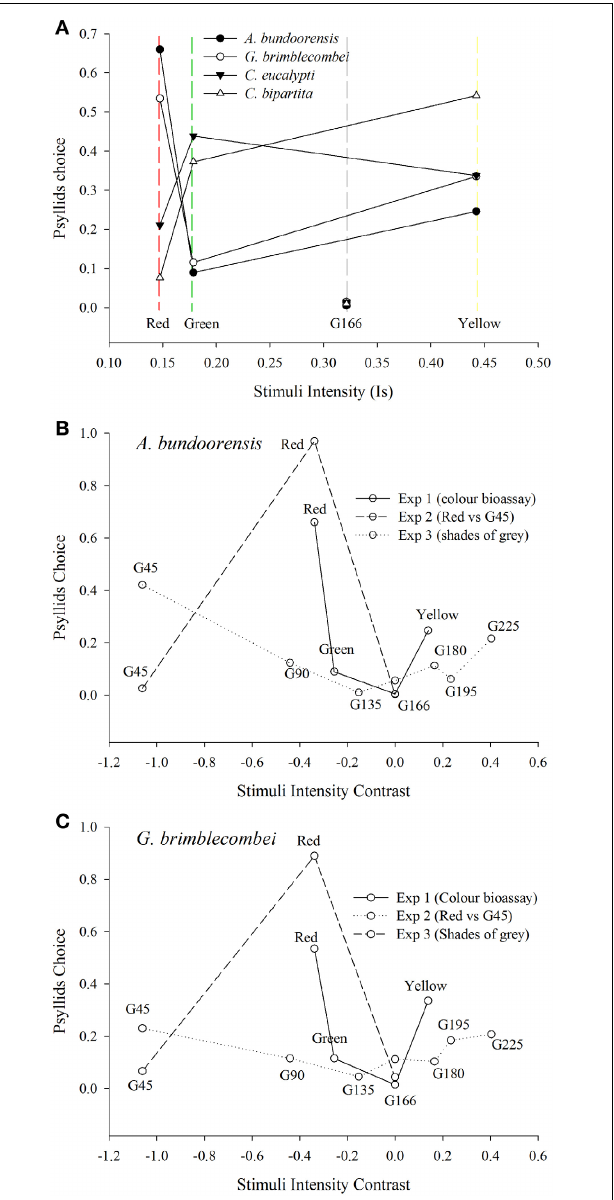
FIGURE 7 | Influence of stimuli intensity on psyllid choices (A) Shows the influence of stimuli intensities (see Equation 1) on the proportion of choosing psyllids. (B,C) represents psyllids choices according to the intensity contrast of the stimuli (see Equation 2) against the background used in the different behavioral